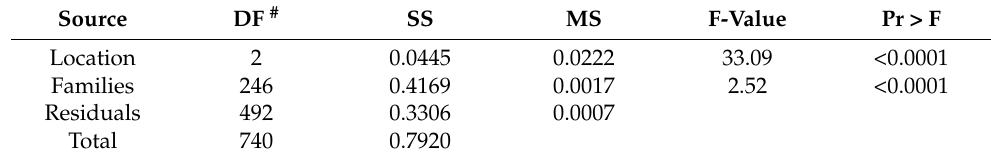
Table 2. Analysis of variance for inducibility across three locations using angular-transformed data. Source